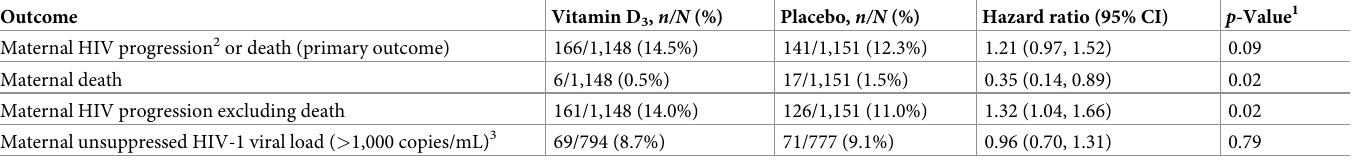
Table 2. Effect of vitamin D 3 supplementation on maternal HIV progression or